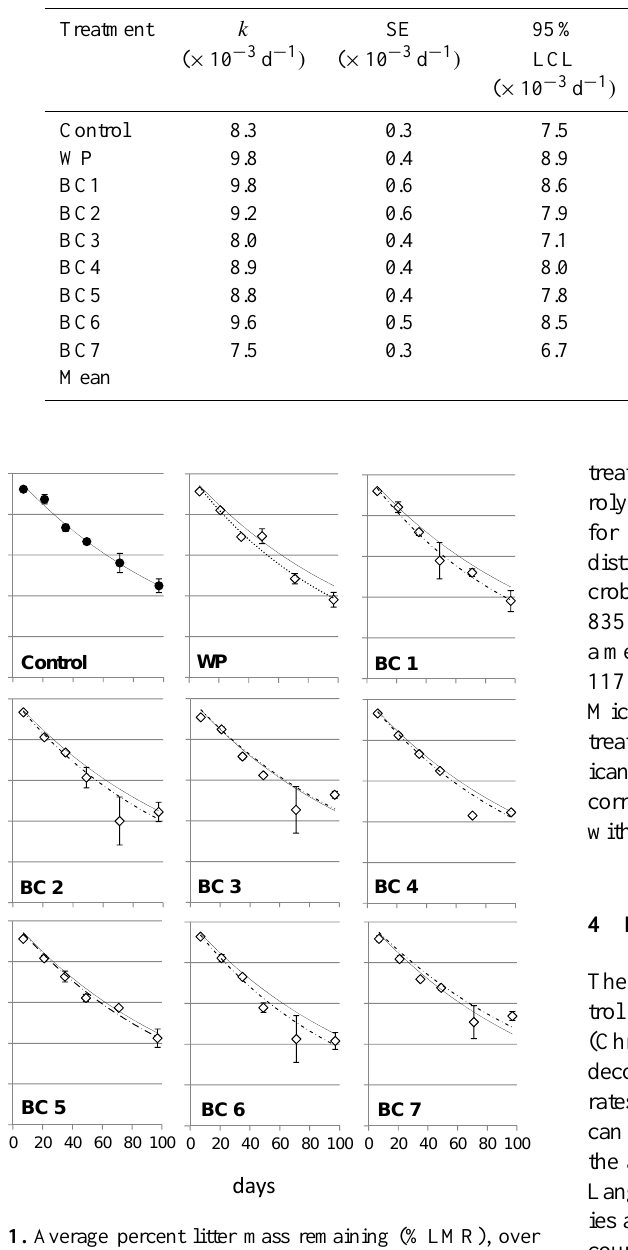
Table 2. Decomposition rate constant, k , with standard error (SE) and 95% lower and upper confidence limits (LCL, UCL), model fit ( r 2 ) , and microbial biomass carbon (MBC) with SE